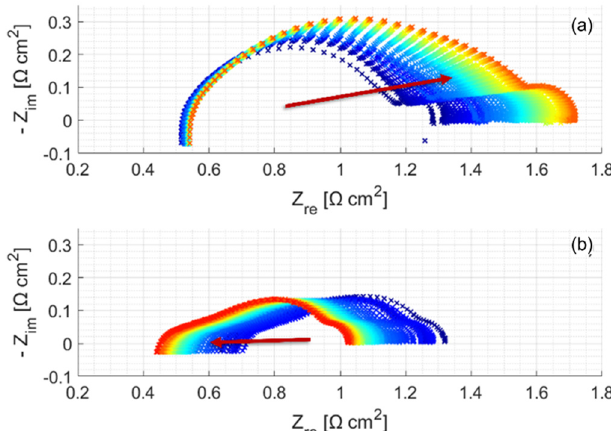
Figure 6. EIS (Nyquist plot) recorded during electrolysis durability tests on ( a ) the ceramic fuel electrode supported SoA cell and ( b ) the metal supported cell at 650 °C, − 0.25 A/cm 2 . The frequency of recording was every 12 h during the first 100 h followed by every 8 h for 140 h, and finally every 6 h for the last period. Increasing operating time from blue to red curves (arrow).